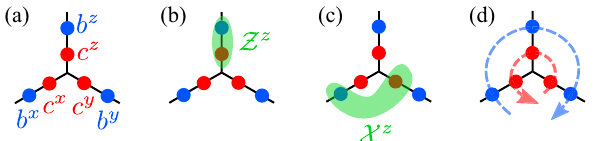
FIG. 6. Majorana representation of a spin- 3 = 2 . (a) Our four- state system (encoding the dimers on a triangle of the kagom´e lattice) represented by six Majorana operators with a parity constraint ib x b y b z c x c y c z ¼ 1 . (b) Diagonal string operator Z α introduced in Eq. (3) (which measures the parity of dimers) represented as ib α c α (shown for α ¼ z ). (c) The off-diagonal string operator X α introduced in Eq. (7) (which shuffles dimers around) is represented as ib α þ 1 c α − 1 on the A sublattice (shown for α ¼ z ). (d) Off-diagonal string operator X α transformed into the diagonal operator Z α [34] by permuting the Majoranas, e.g., c x → c y → c z → c x and b x → b z → b y → b x , thereby making it a measurable observable in Rydberg atom arrays